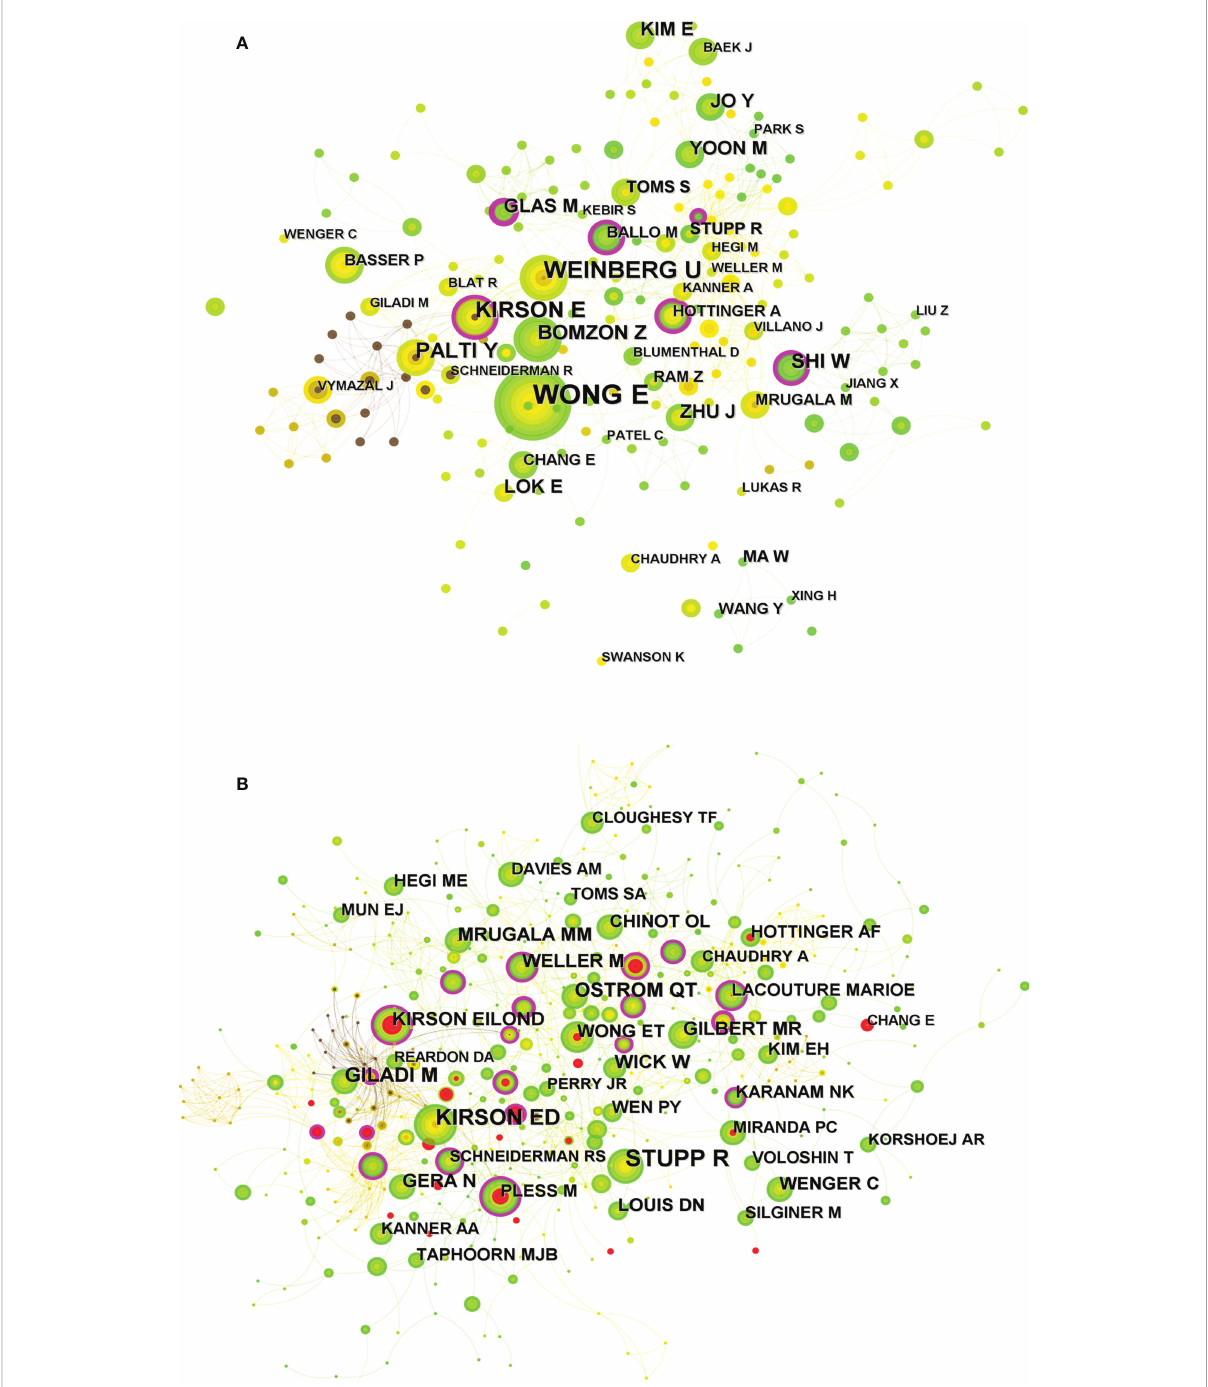
FIGURE 4 (A) Visual mapping of the authors of related publications. A circle represents an author, with larger circles representing more publications by that author, and the purple ring on the outer ring represents having a high centrality. (B) Visual mapping of co-cited authors of related publications. A circle represents a co-cited author, with larger circles representing more publications by that co-cited author, and the purple ring on the outer ring represents a high